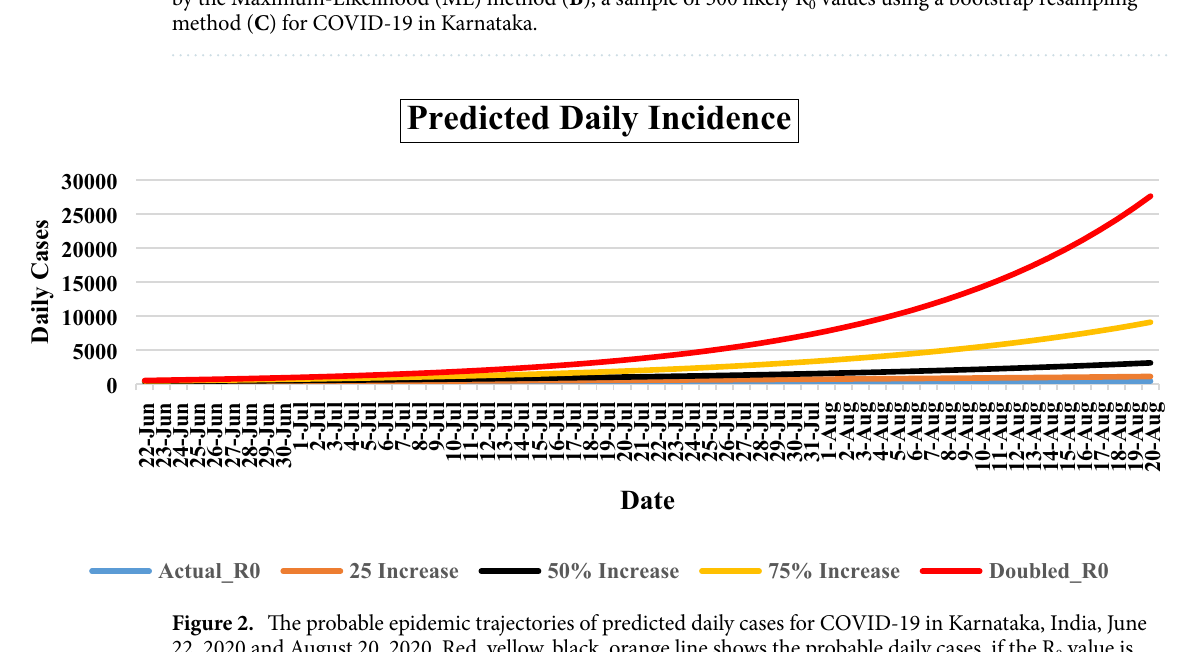
Figure 2. The probable epidemic trajectories of predicted daily cases for COVID-19 in Karnataka, India, June 22, 2020 and August 20, 2020. Red, yellow, black, orange line shows the probable daily cases, if the R 0 value is doubled, 75%, 50% and 25% respectively. Blue line shows the probable number of daily cases, if R 0 value was unchanged, for the next 60